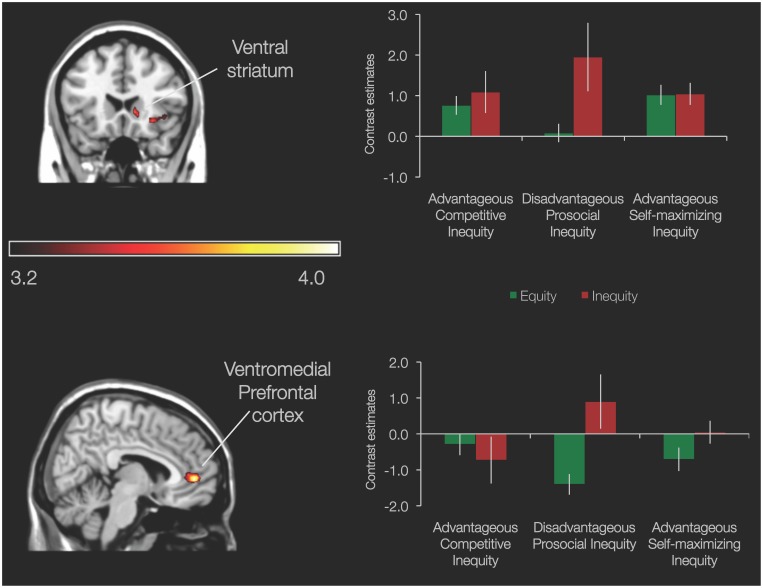
Neural network involved in Disadvantageous Prosocial Inequity.Ventral striatum (MNI 12, 21, 0) and ventromedial PFC (MNI 6, 48, 0) from the Inequity > Equity contrast in the Disadvantageous Prosocial Inequity condition; p<.001, 10 voxel threshold. Bar graphs display contrast estimates obtained from ROI analyses for inequity and equity choices in the three conditions. Error bars indicate SEM.